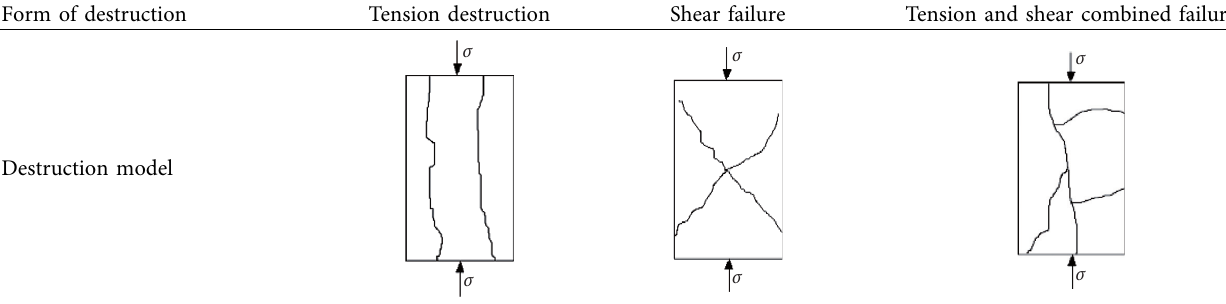
Table 9: Comparison of failure modes between rockburst similar materials and white sandstone covered by the study. The failure modes of rockburst similar materials and original rock can be divided into tension failure, shear failure, tension, and shear failure. Form of destruction Tension destruction Shear